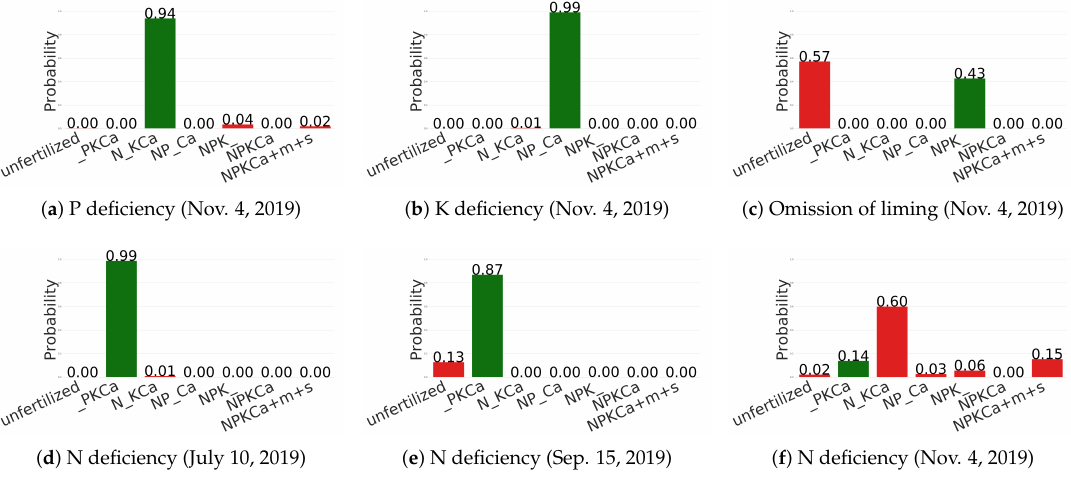
Figure 8. Histogram diagram of probability distribution over seven classes of nutrient treatments. Green bars indicate correct predictions while red bars indicate wrong predictions. The corresponding test images are shown in Figure